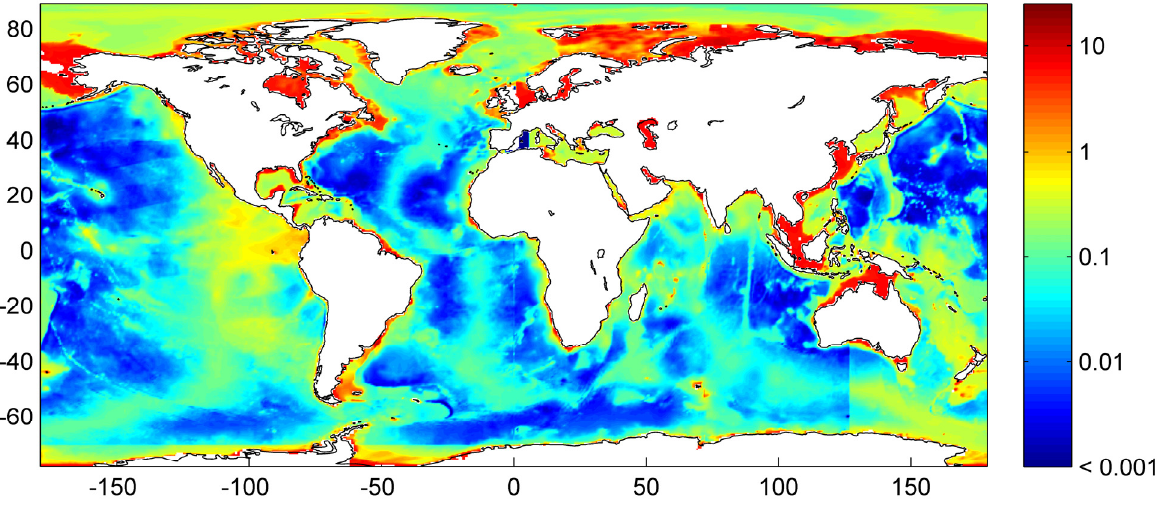
Figure 2. Accumulation rate of POC in Holocene surface sediments in g m − 2 yr − 1 at 0.5° × 0.5° spatial